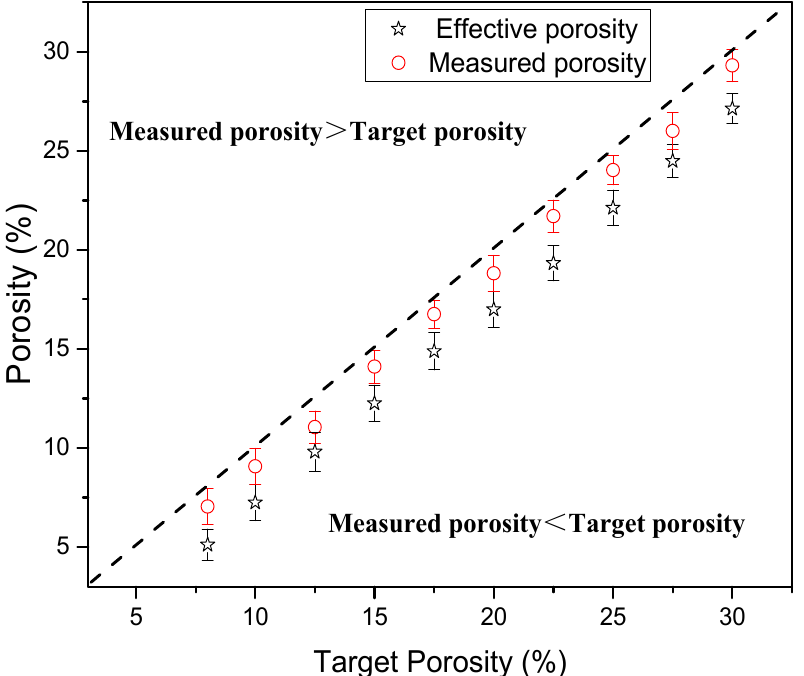
Figure 5. Effective porosity and measured porosity of the pervious concrete with different target porosities.